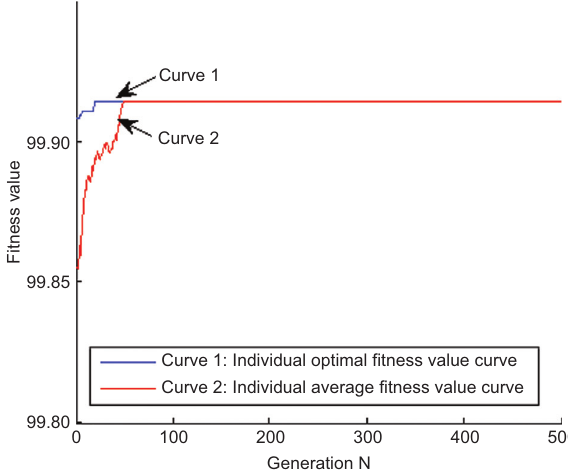
Figure 14. The Convergence Curve when the Mutation Probability is Set to (0.008,